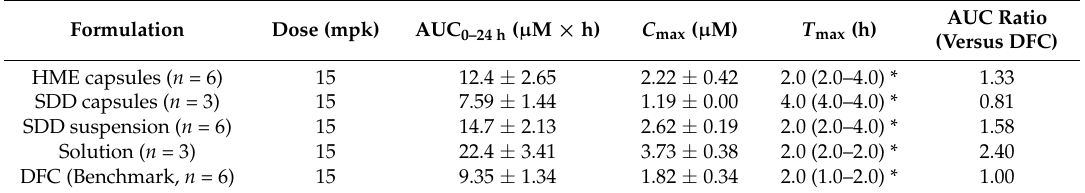
Formulation Formulation